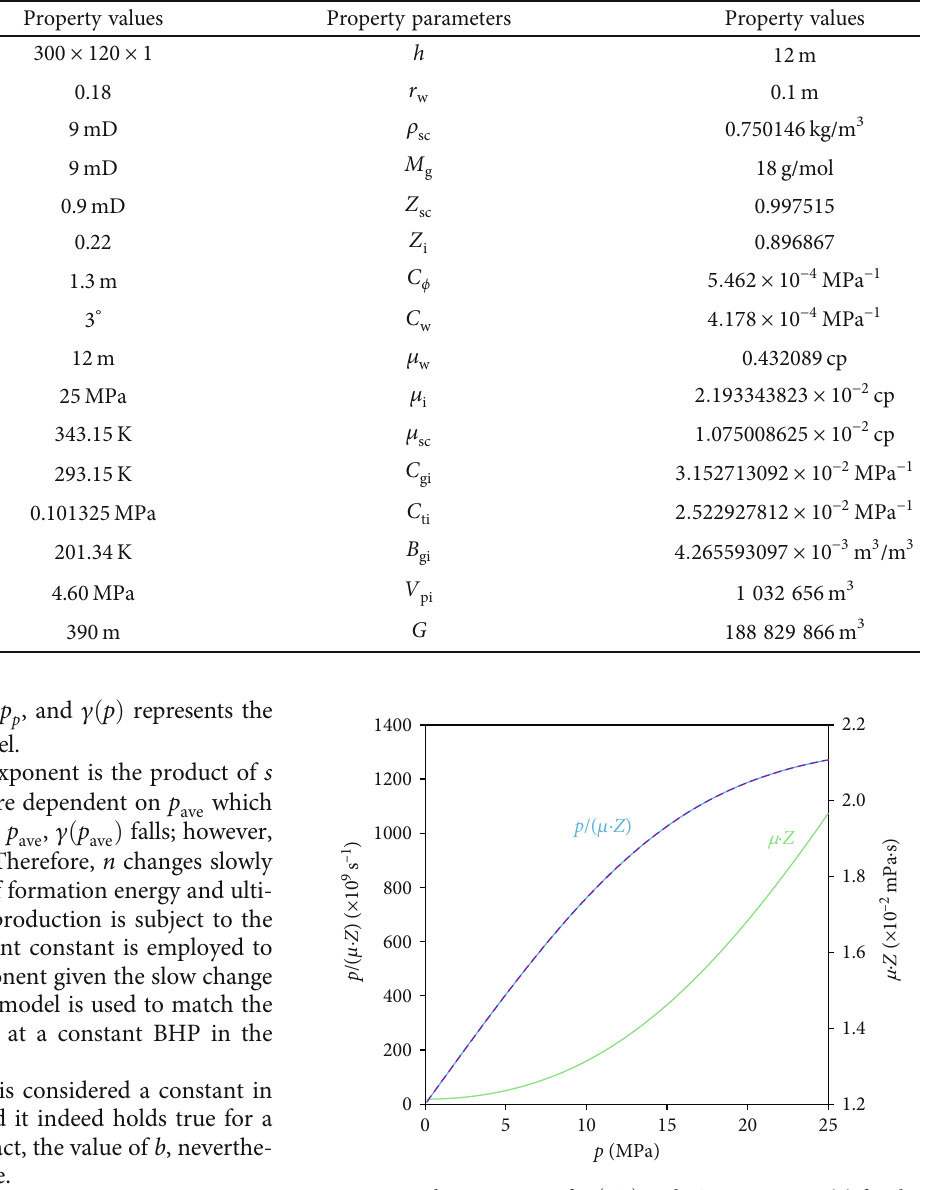
Figure 1: Relation curves of p / ð μ Z Þ and μ Z vs. pressure ( p ) for the normal pressure